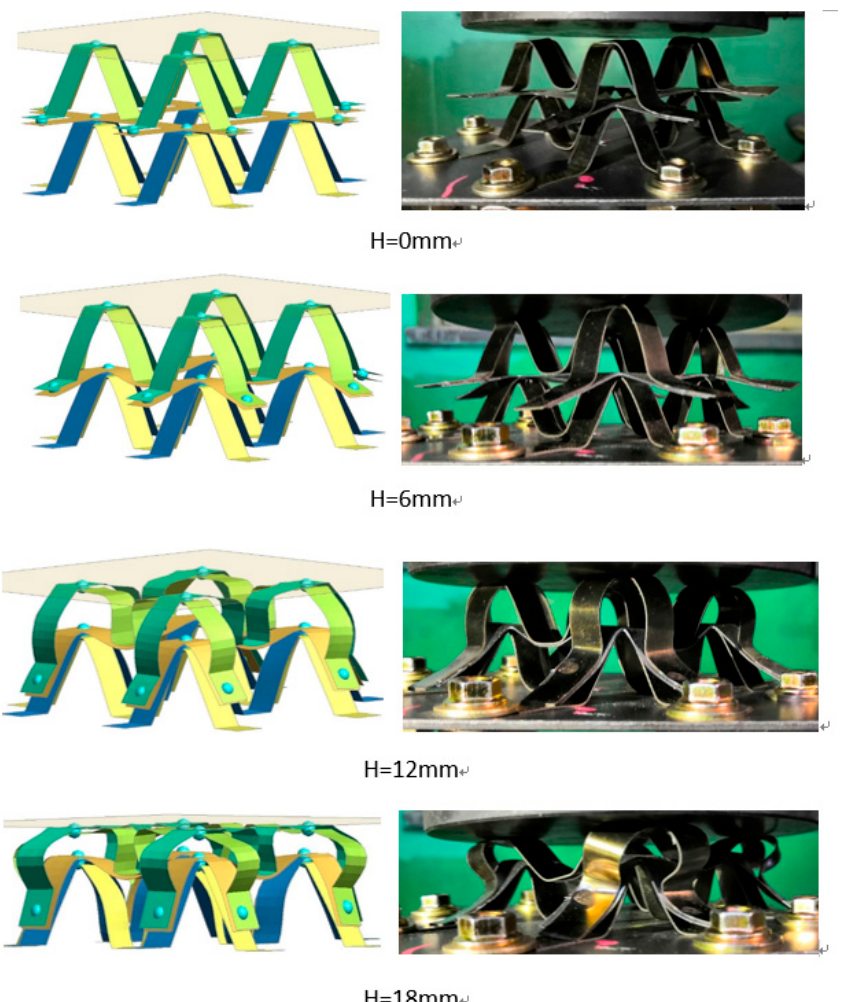
Figure 11. Schematic diagram of interlayer relationship of double-layer composite module.